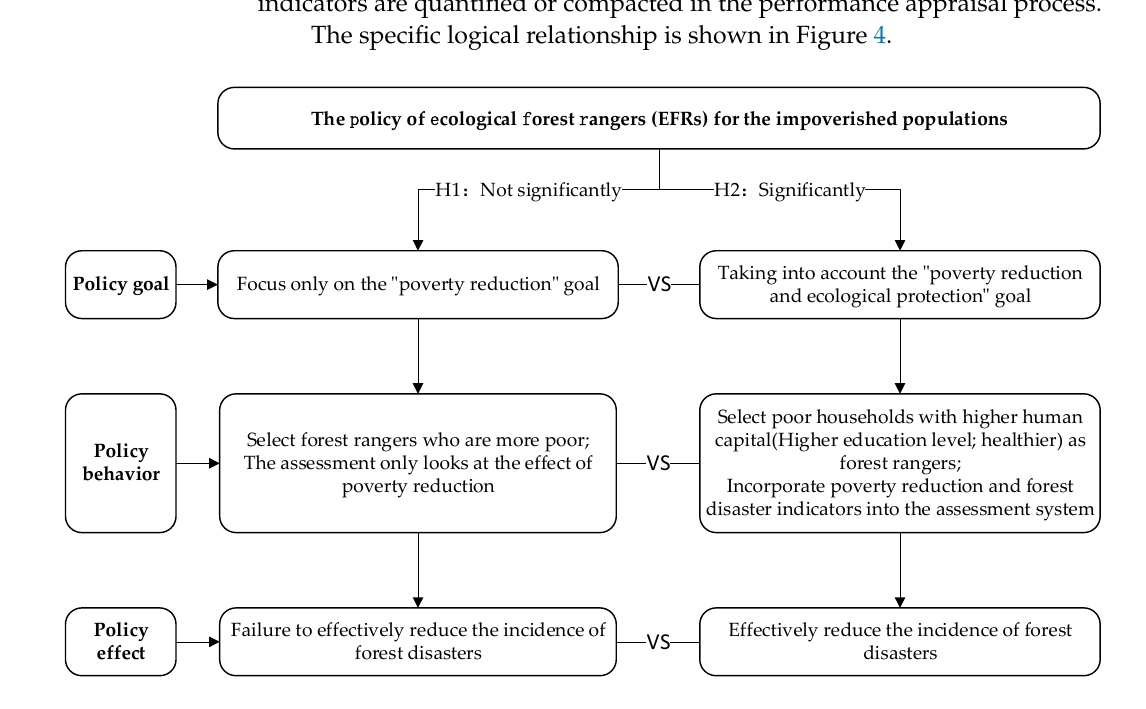
Figure 4. The logical relationship between the policy and the occurrence of forest disasters .